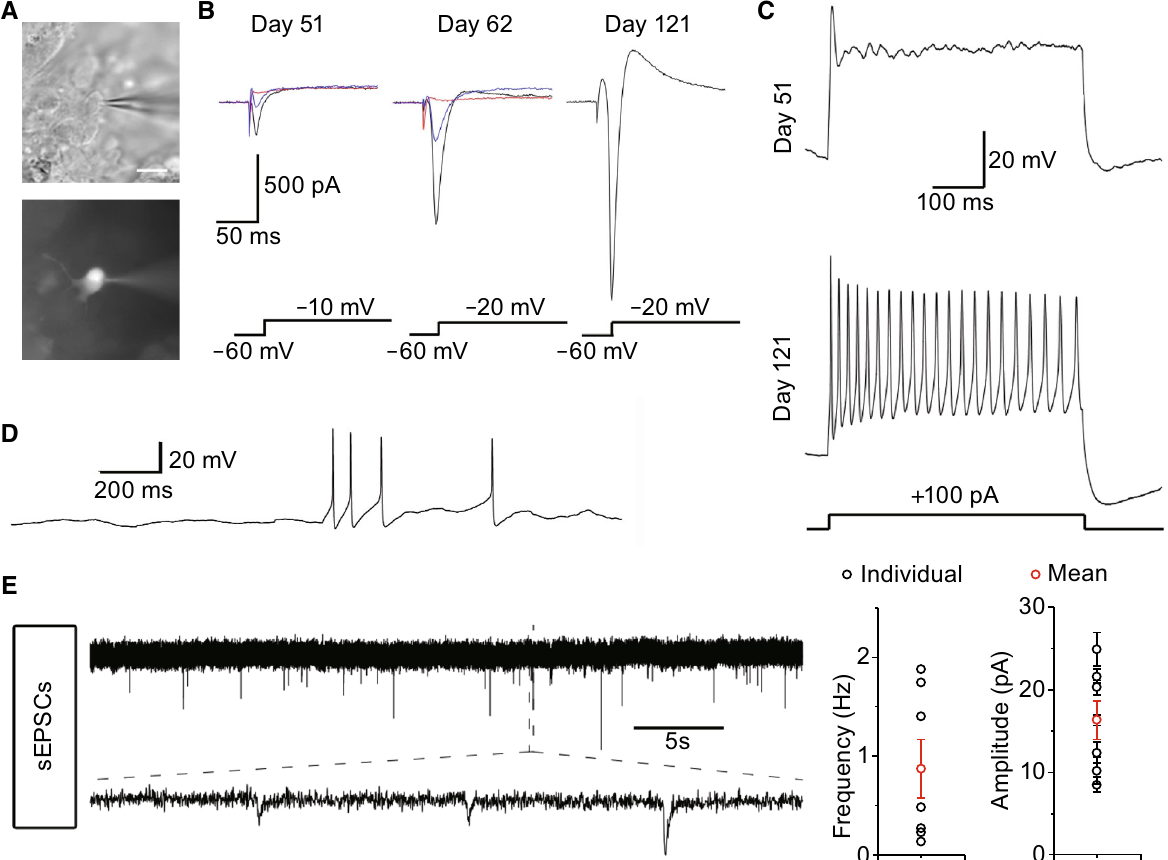
Figure 3. Physiological properties of cells in organoids at different stages. (A) An example of cells in organoids recorded under DGC (top) and fl uorescence (bottom). (B) Representative traces of membrane currents (black) evoked by depolarizing pulses of − 10 mV or − 20 mV. The Na + currents were blocked by 1 μ mol/L tetrodotoxin (TTX, red) and recovered (blue) after rinsing. (C) Representative traces of membrane potentials in response to a 500-ms current injection from a 51- (top) or 121-day-old (bottom) organoid. (D) Spontaneous action potentials were recorded from a 121-day-old organoid. (E) Spontaneous EPSCs in mature organoids. The average frequency and amplitude are shown on the right. n = 7 cells. All data are presented as means ± s.e.m. Scale bar: 20 μ m in